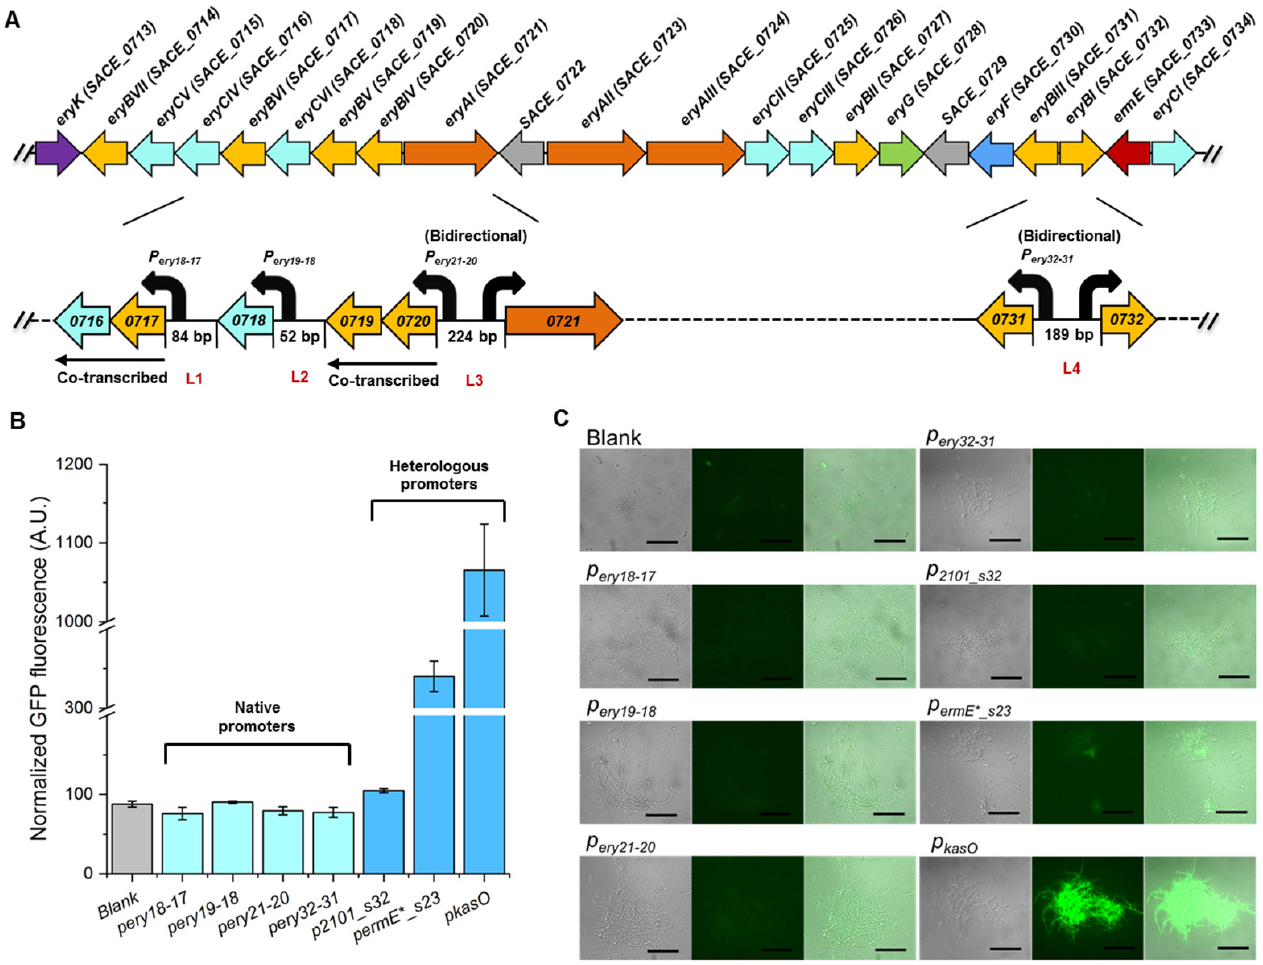
Figure 1. Activity determination of different promoters. ( A ) Ery biosynthetic gene cluster. Four native promoters are indicated by black arrows. Four loci for promoter engineering are indicated in red characters. ( B ) Relative strengths of native and heterologous promoters. The normalized fluorescence of the wild-type S. erythraea NRRL23338 was used as the blank control. Error bars represent standard deviations calculated from three independent biological replicates. ( C ) Microscopy of eGFP expressing strains harboring different promoters. Scale bar: 50 μM.